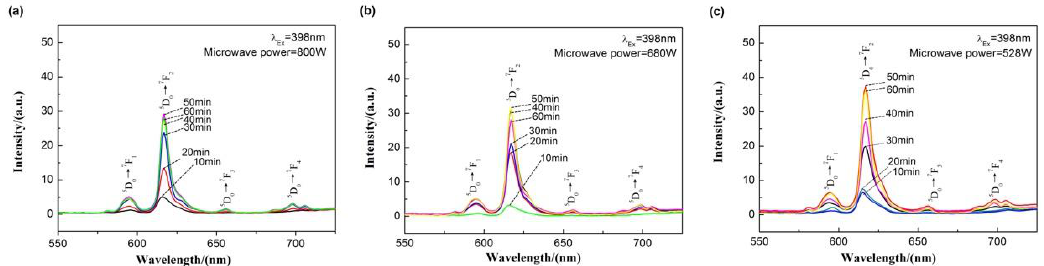
Figure 9. Emission spectra under an excitation wavelength of 398 nm of the Ca 0.97 TiO 3 :Eu 3 + 0.03 prepared at different microwave sintering power. ( a ) 800 W; ( b ) 680 W; ( c ) 528 W.